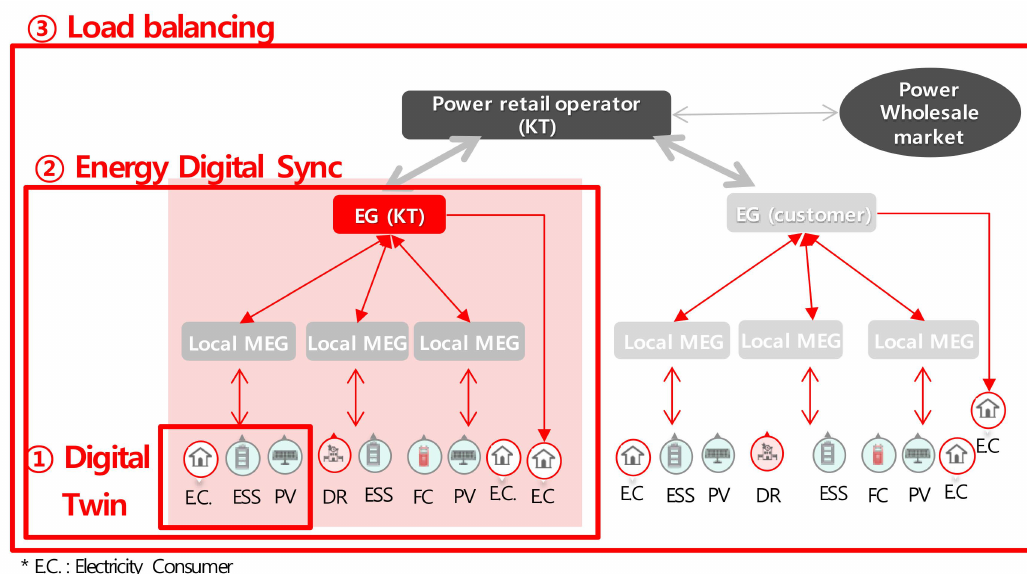
Figure 16. Illustration of technologies for Korea Telecom (KT) intelligent